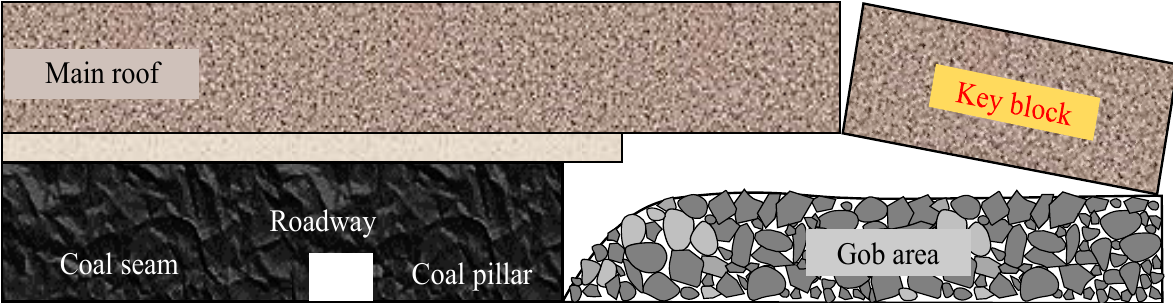
Figure 10. Structural model of elastic foundation beam [49].